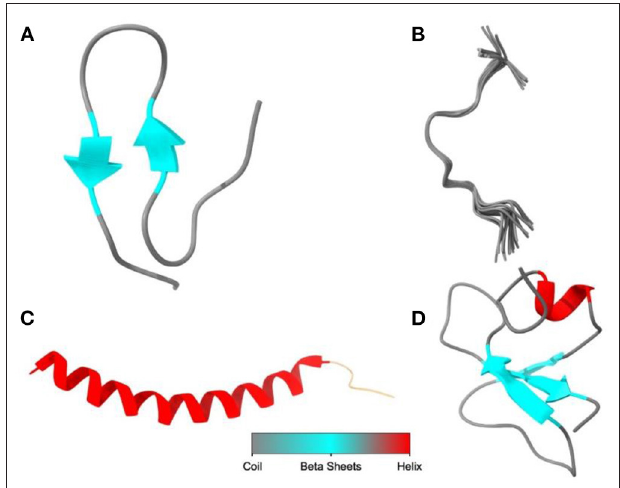
FIGURE 2 | The diagram illustrated the main structural classes of AMPs: (A) β -sheet, defensins, and protegrins; (B) extended, indolicidin; (C) α -helical, nisin, and lactoferricin; (D) loop or combined structure, plectasin. The image was created using UCSF Chimera